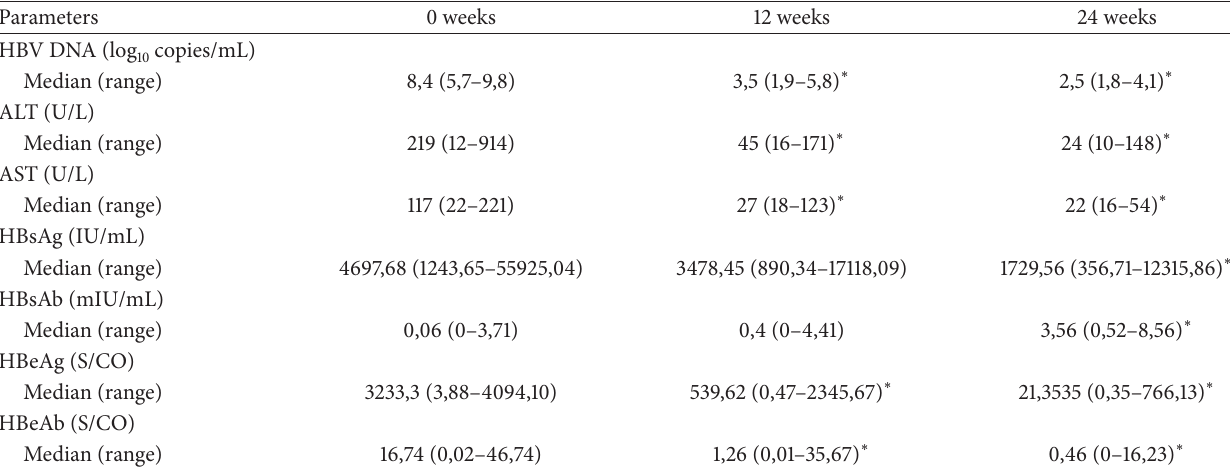
Table 3: Treatment with adefovir dipivoxil modulates clinical profiles of HBV